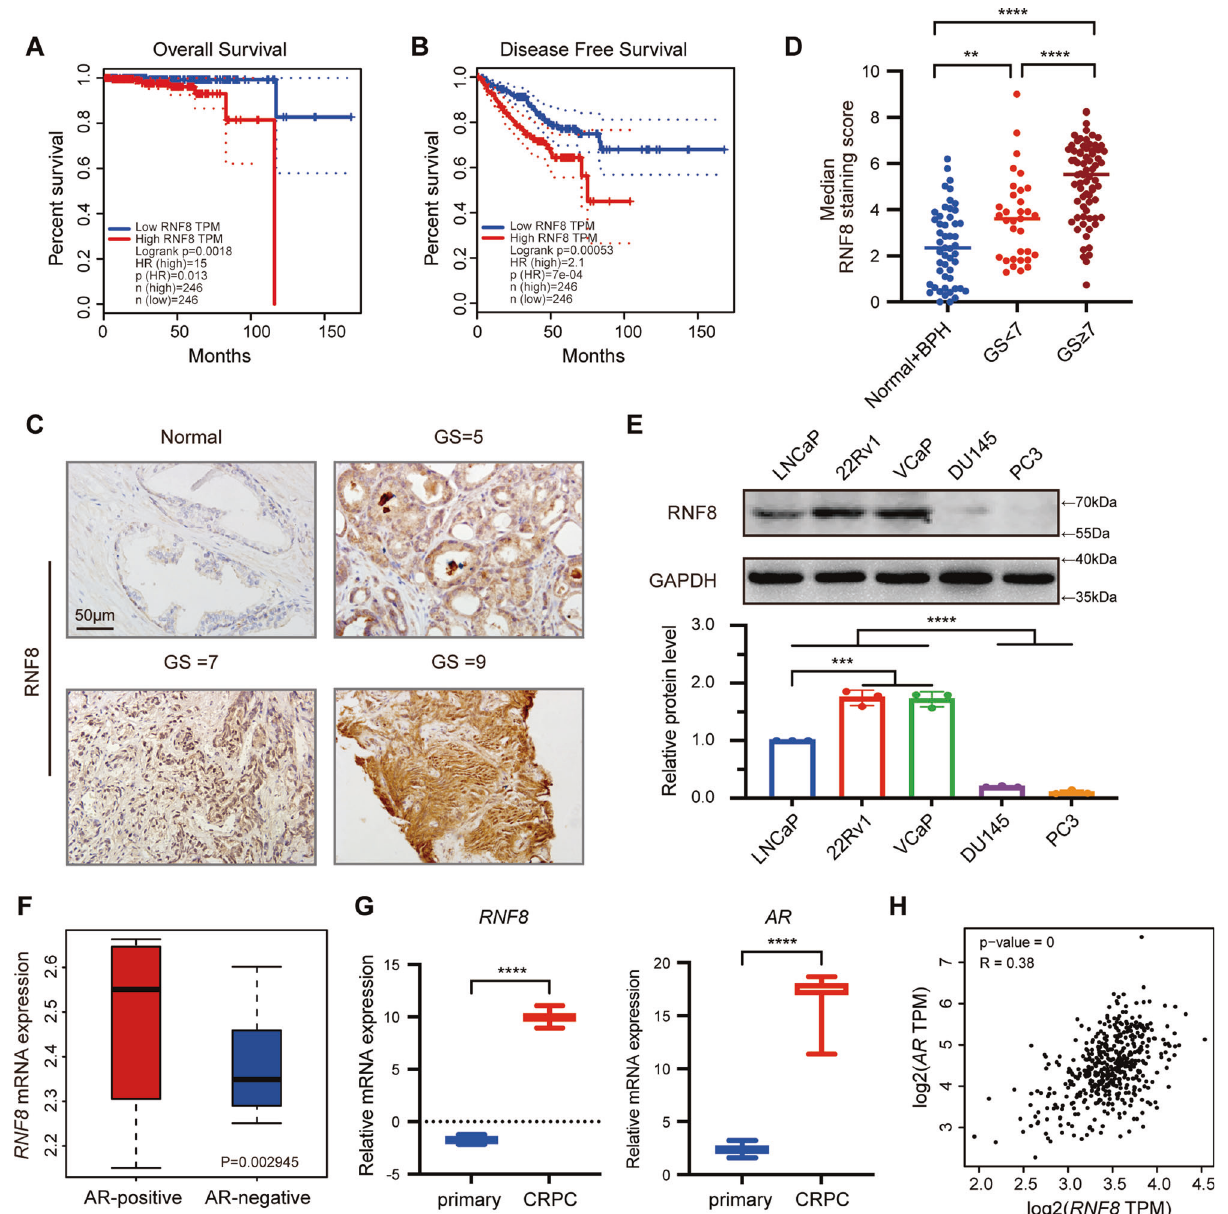
Fig. 1 The expression of RNF8 is increased in advanced prostate cancer and positively correlated with that of AR. A , B Kaplan – Meier analysis of overall survival ( A ) and disease-free survival ( B ) of PC patients ( n = 246) with low or high expression of RNF8 in